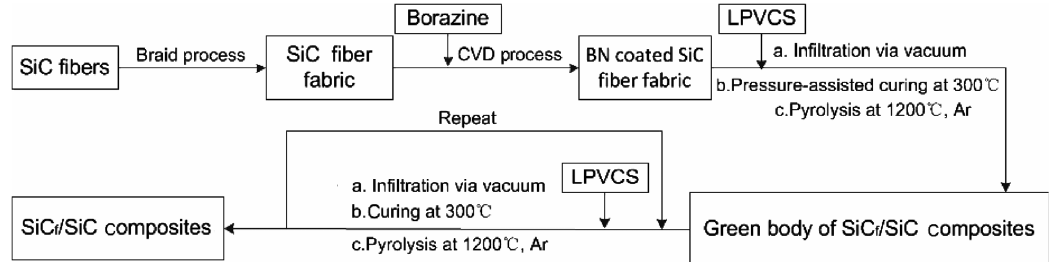
Fig. 1 Flow chart of the fabrication process of the KD-S SiC f /SiC